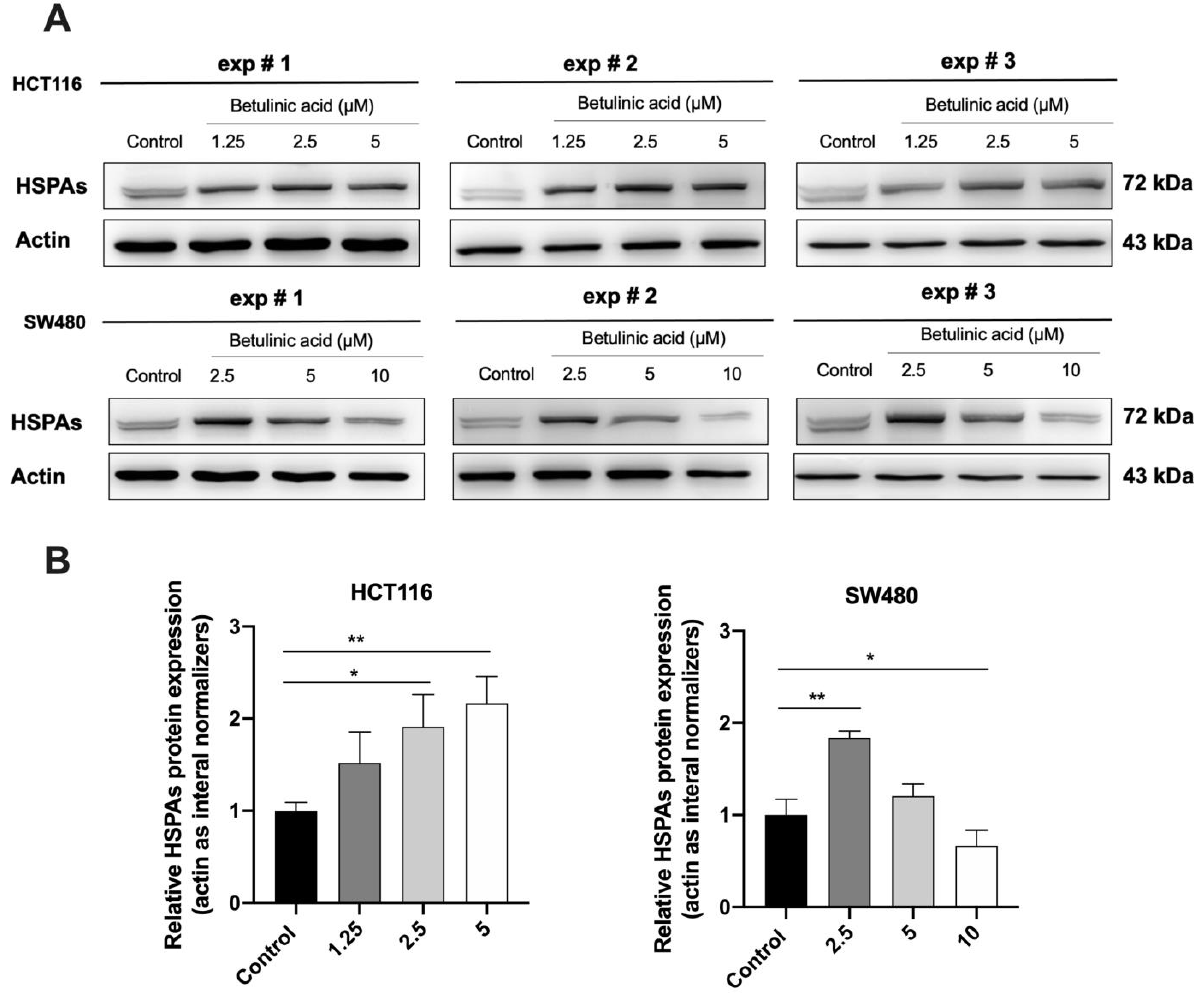
Figure 7. Western blot analysis showing the HSPA’s expressions following the BA treatment in HCT116 and SW480 cell lines ( A ) and their corresponding quantifications ( B ). Actin was used as the internal control. All experiments were triplicate and the results were represented as mean ± standard error of the mean (SEM). One-way ANOVA and with Dunnett’s post hoc test were used to test statistical significance with * indicating p < 0.05, and ** p < 0.01 vs. control group.